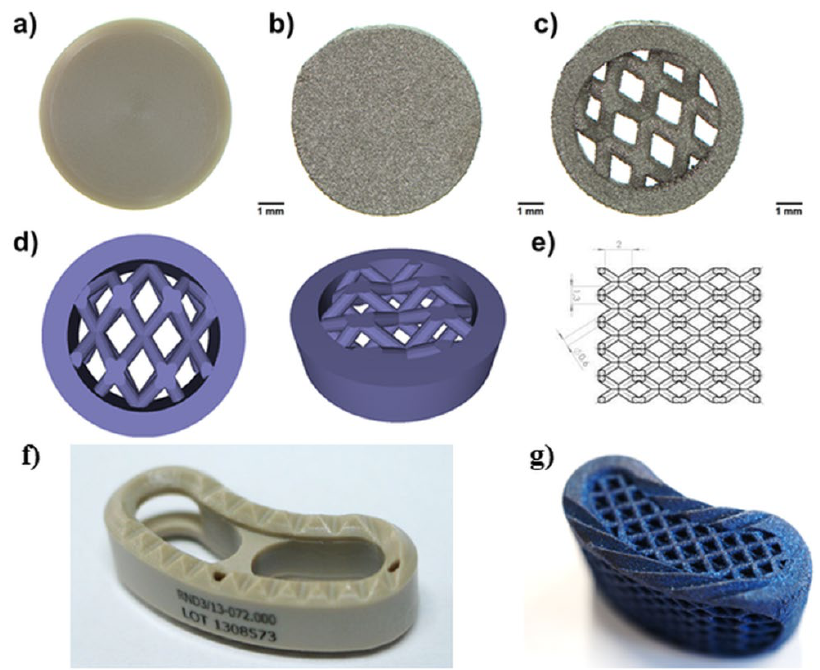
Figure 1. Images presenting tested materials: ( a ) solid PEEK, ( b ) 3D-printed solid Ti6Al4V, ( c ) 3D printed mesh Ti6Al4V, ( d ) the 3D model for the production of the mesh sample was designed using SOLIDWORKS ® software, ( e ) dimensions of the mesh part of the sample model, ( f ) TLIF PEEK intervertebral cage, ( g ) mesh TLIF 3D-Ti intervertebral cage (made of Ti6Al4V).